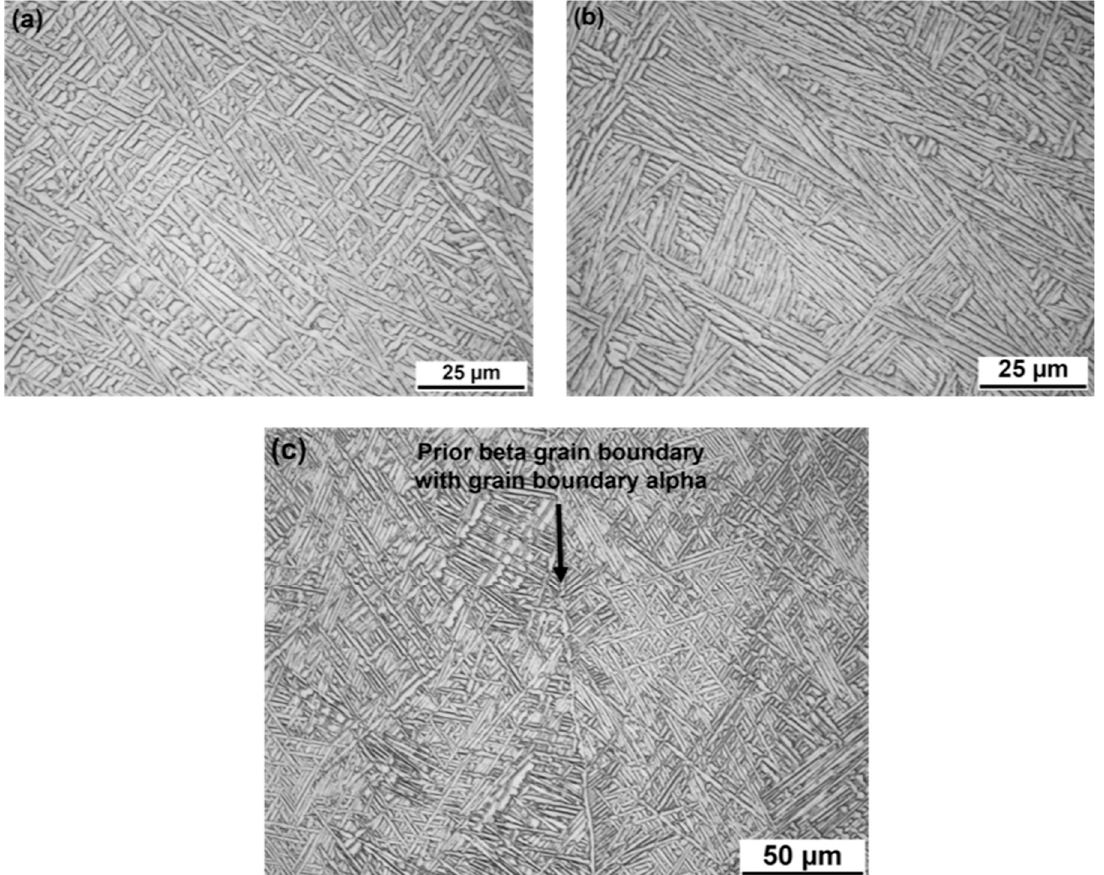
Figure 6. Light optical micrographs showing the microstructure of the GTAW wire feed built Ti-6Al-4V consists of fine α laths in the form of ( a ) basketweave α or ( b ) colony α structure. The prior β grain boundary is decorated with grain boundary α ( c ). Table 3. The result of the quantitative material characterization of the three cross-sections containing widths of one, two, and three beads, respectively.